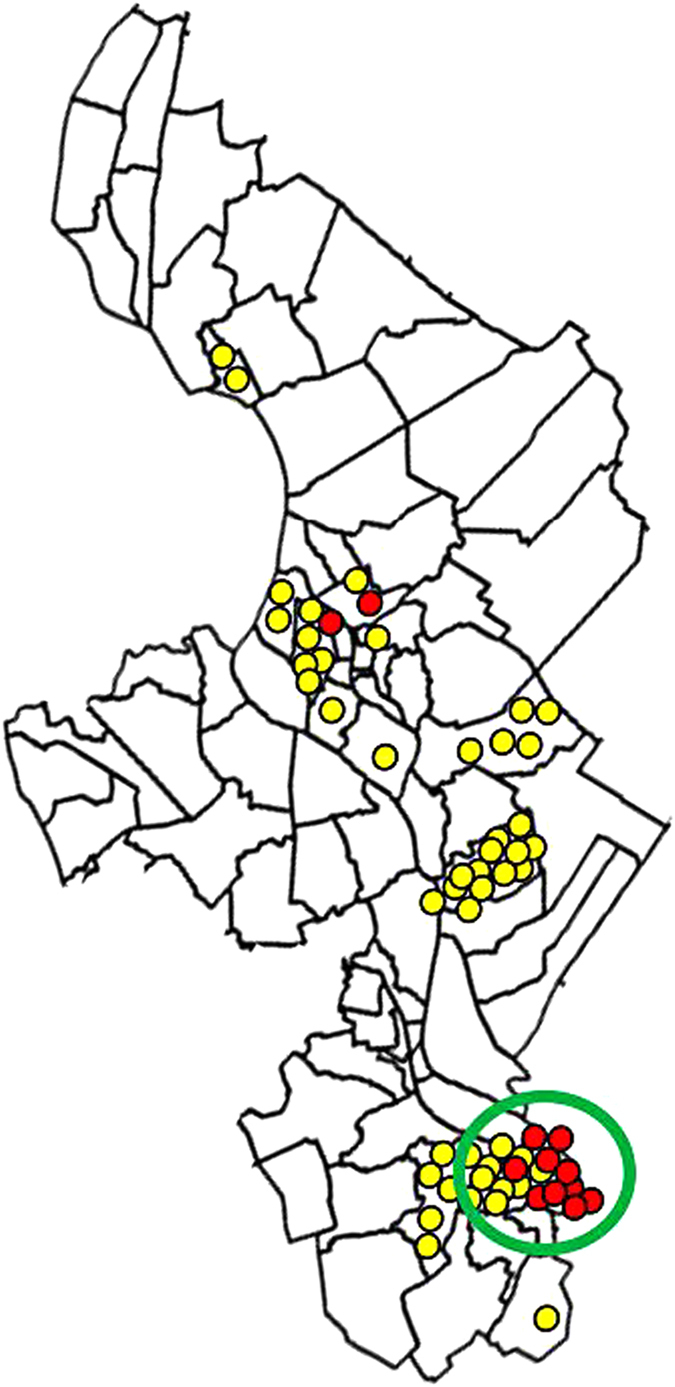
Commune location of households (farm cohorts) with individuals reporting clinical disease for the first time during June and July of 2014, Dong Thap province, Vietnam.Yellow = not reporting disease, red = reporting disease. The circle highlights the location of Commune A in Dong Thap province. (Maps created using Qgis version 2.2 software).